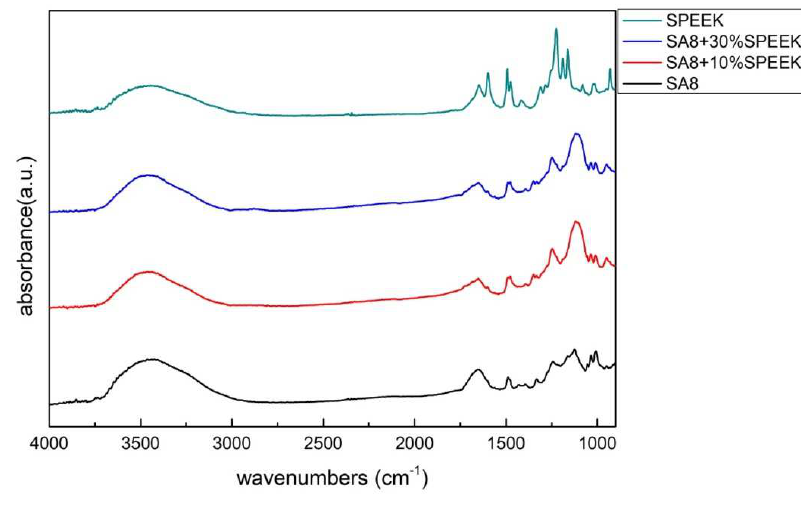
Figure 7. FT-IR spectra of SA8 blended with sPEEK series at 4000–900 cm −1 .